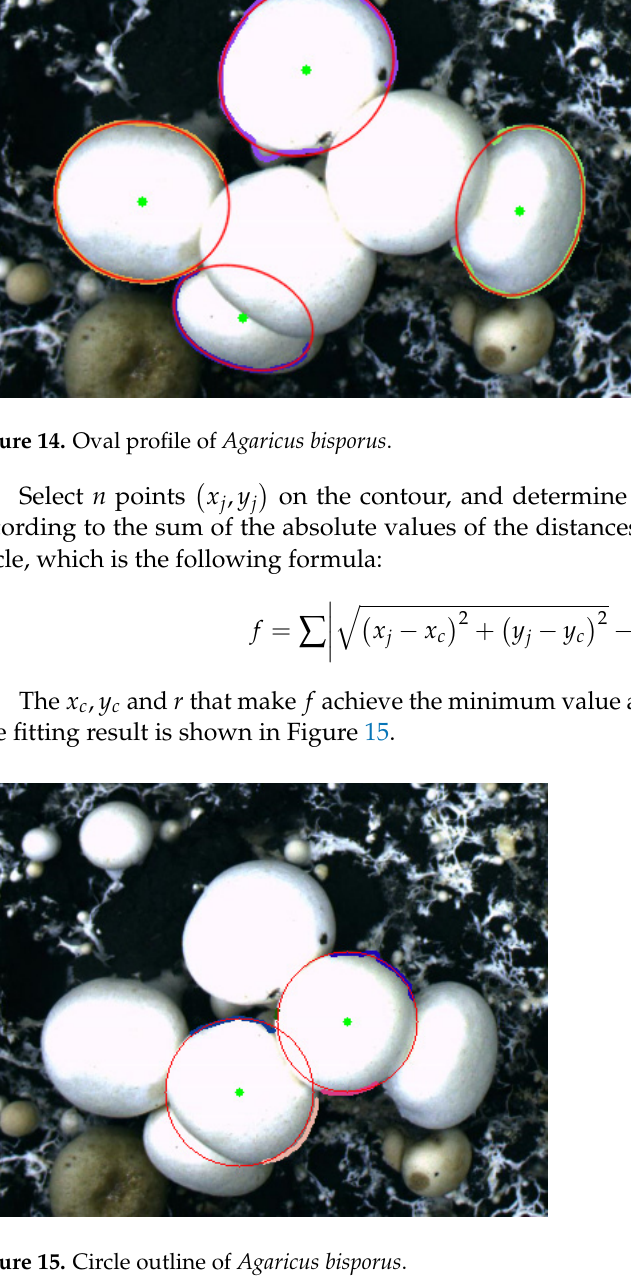
Agaricus bisporus is shown in Figure